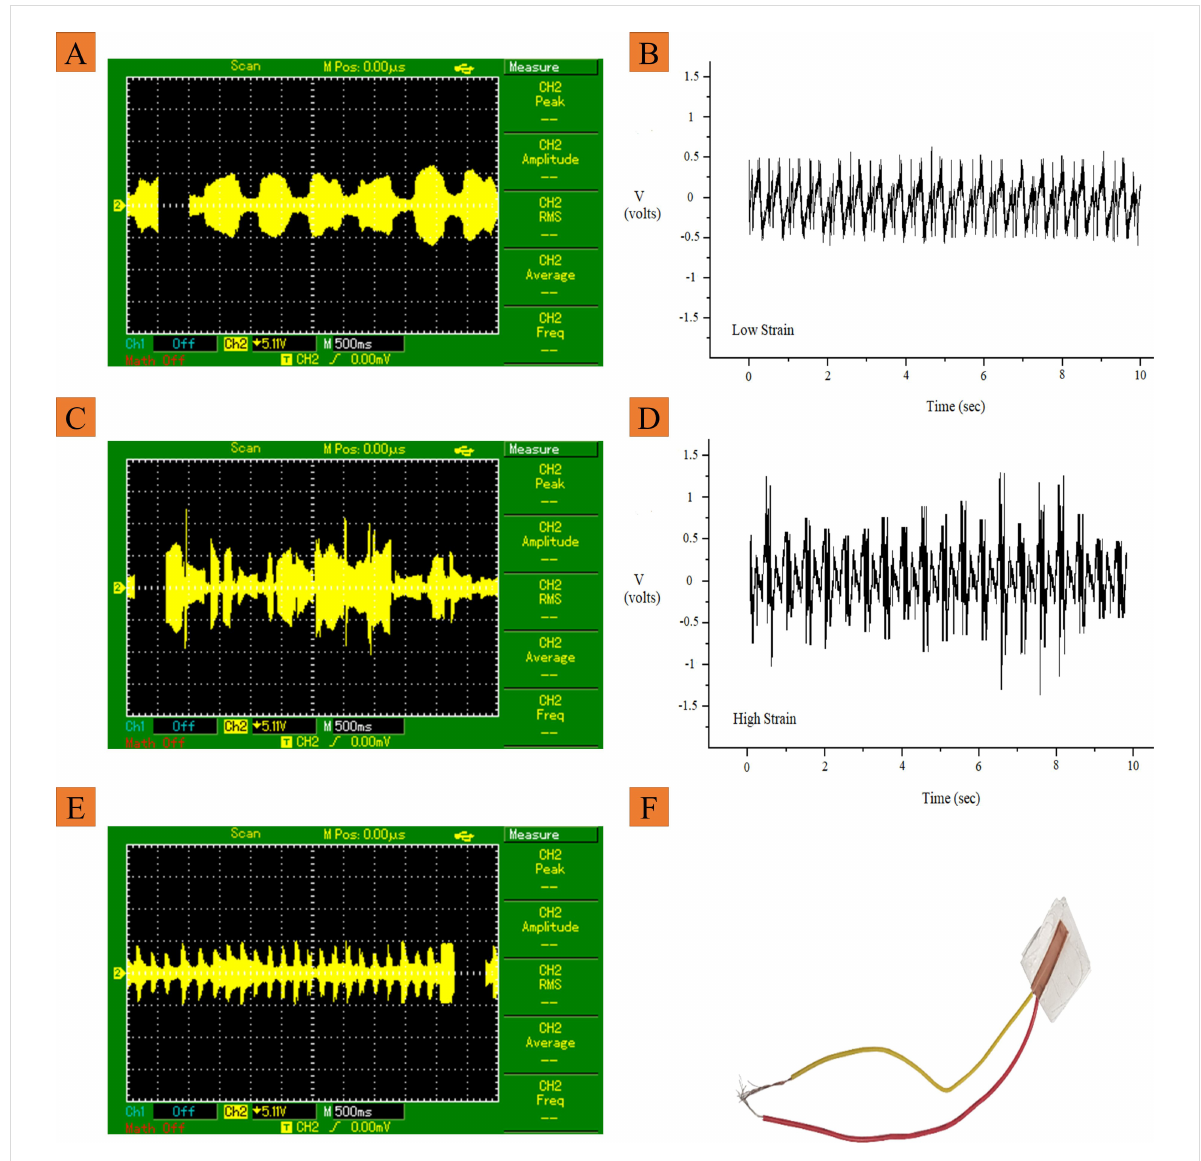
Figure 4: Digital oscilloscope graph of the sensor under low dynamic strain (A), the output voltage under low dynamic stress (B), digital oscilloscope graph of the sensor under high dynamic strain (C), the output voltage under high dynamic stress (D), digital oscilloscope graph of the sensor under low dynamic strain but with high frequency (E), and a piezoelectric sensor developed from 16 wt % solution